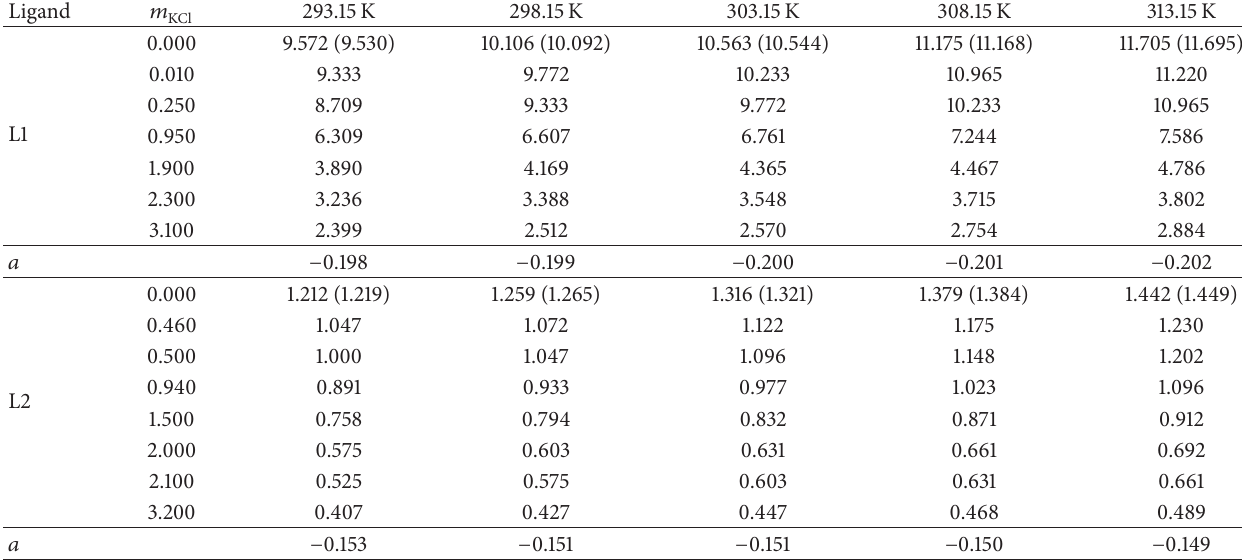
Table 5: Total molal solubilities 𝑆 T × 10 −3 , mol/kg −1 (or molal solubilities of neutral species, 𝑆 0 × 10 −3 , mol/kg −1 ), of L1 and L2 at different ionic strength in aqueous KCl and at different temperatures.